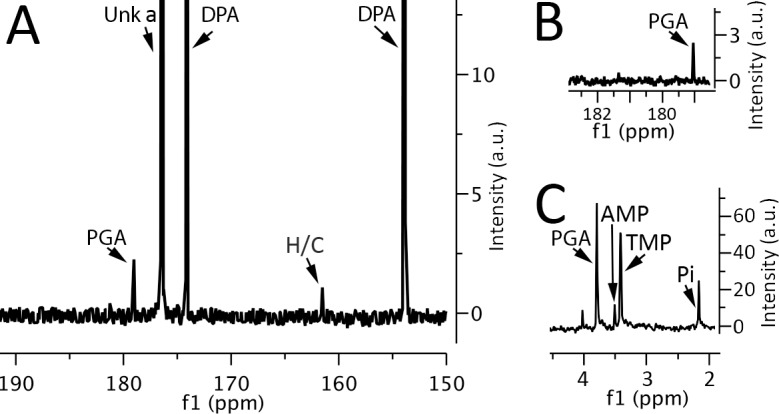
13C-NMR and 31P-NMR spectra of small molecules extracted from spores of Clostridium difficile.Spores of C. difficile strain CD630, ~ 35 mg dry wt, were extracted with Procedure 1, the extract processed, ultimately dissolved in 700 μl of D2O plus appropriate buffer, and NMR spectra were collected as described in Methods. The various panels are the: A) 13C-NMR spectrum of the extract; B) expanded 13C-NMR spectrum of the extract in the region where L-malate peaks would be expected; and C) 31P-NMR spectrum of the extract. In panels A,B) peaks due to 3PGA (PGA), HCO3-1/CO3-2 (H/C) and DPA are labeled, as is a peak given by an unknown compound (Unk a). In panel C) the identified peaks are PGA, AMP and inorganic phosphate (Pi). The TMP peak in panel C is from 175 nmol of thymidine-monophosphate added as a standard.